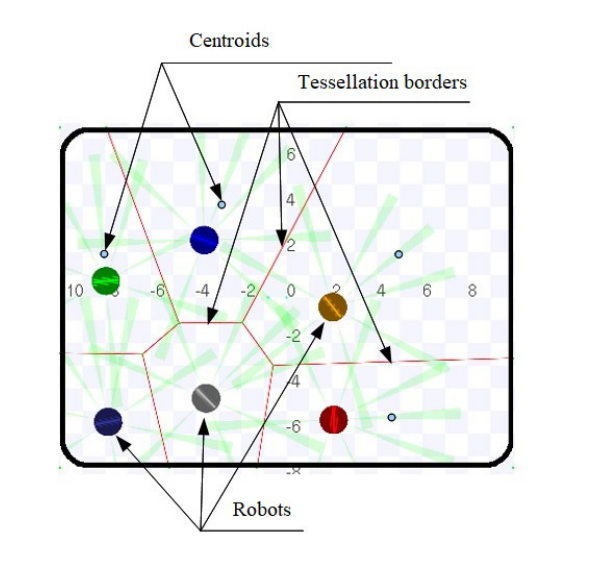
Figure 4: Results of the algorithm execution.